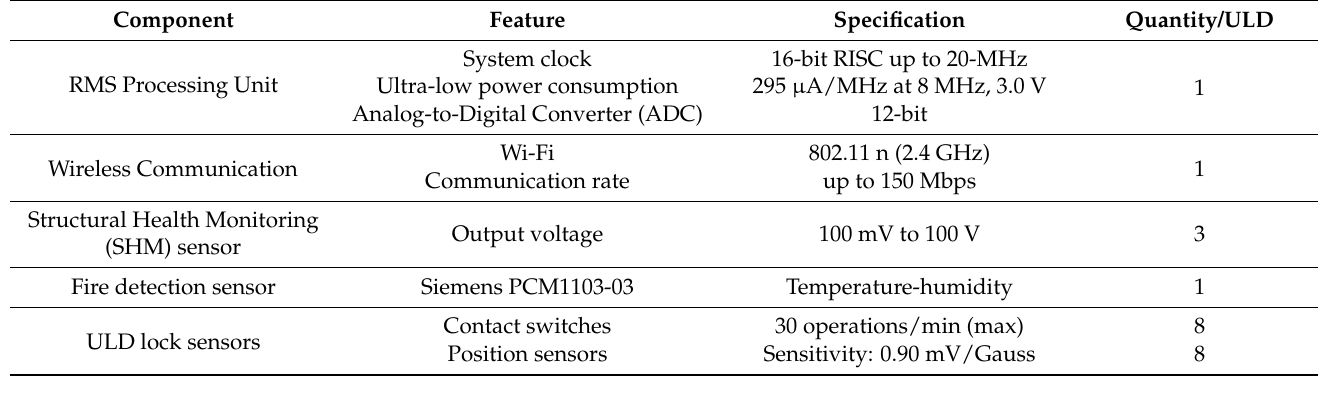
Table 1. Remote Monitoring System technical specifications.